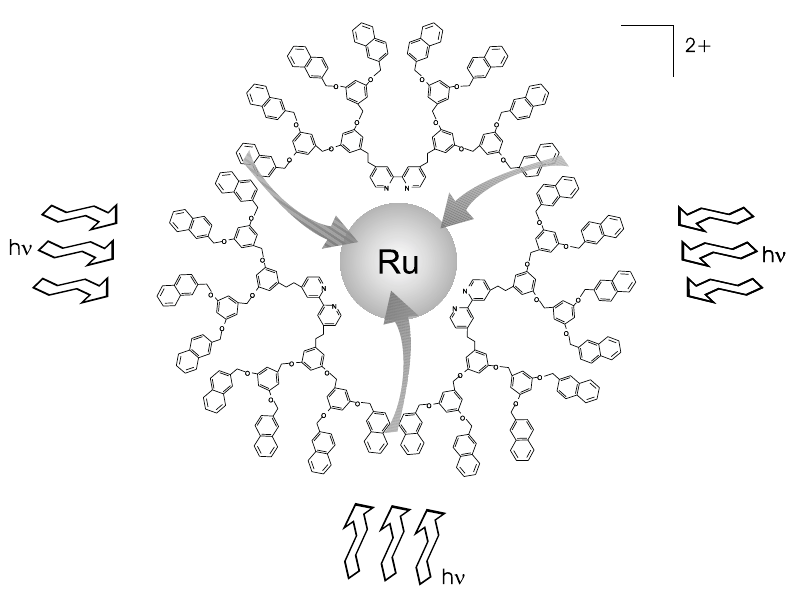
Fig. 3 – Schematic representation of ligth absorption and energy-transfer processes in the naphthalene substituted dedritic-bpy ruthenium(II)